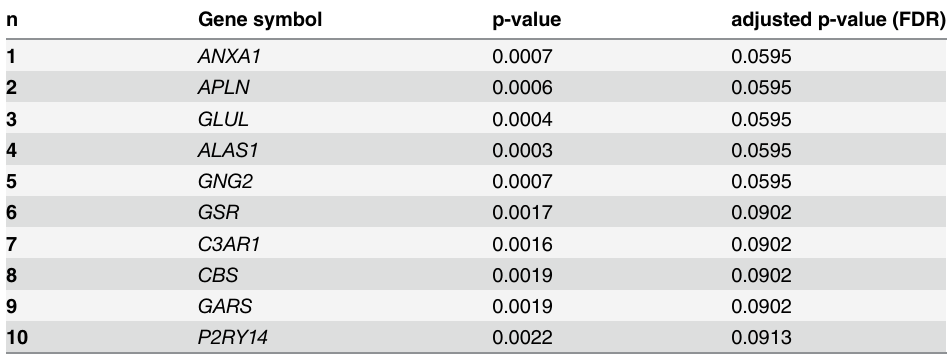
Table 3. Gene expression and BMI.